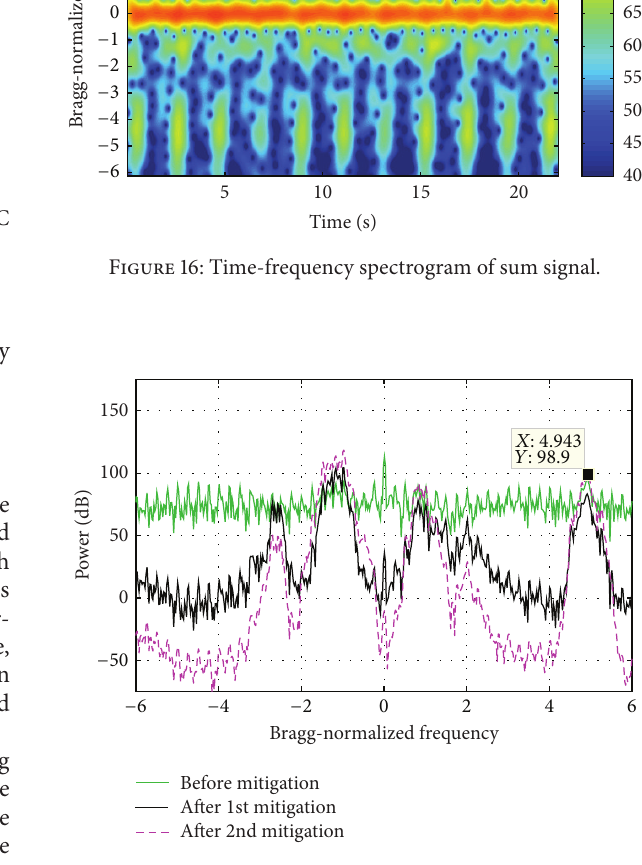
Figure 17: Echo power spectrum density before and after WTC